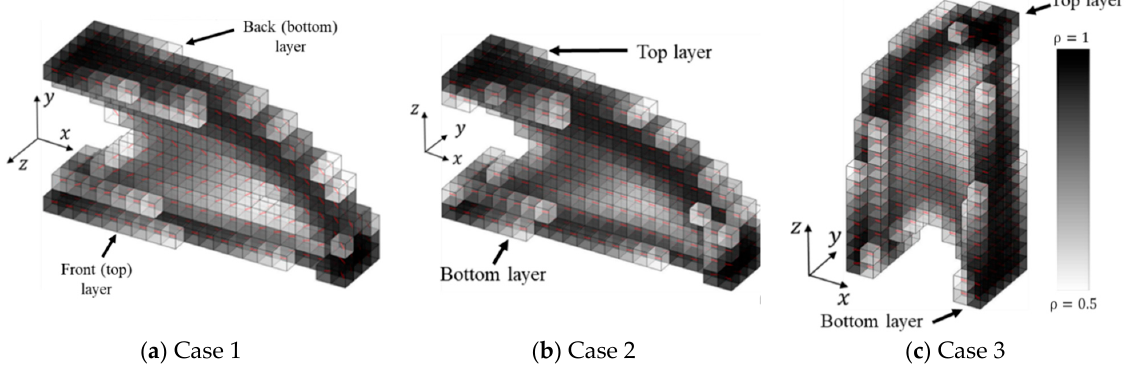
Figure 10. Isometric views of optimal element density values for three different print directions: Cases 1, 2, and 3. Elements with ρ e ≤ 0.5 are not shown.